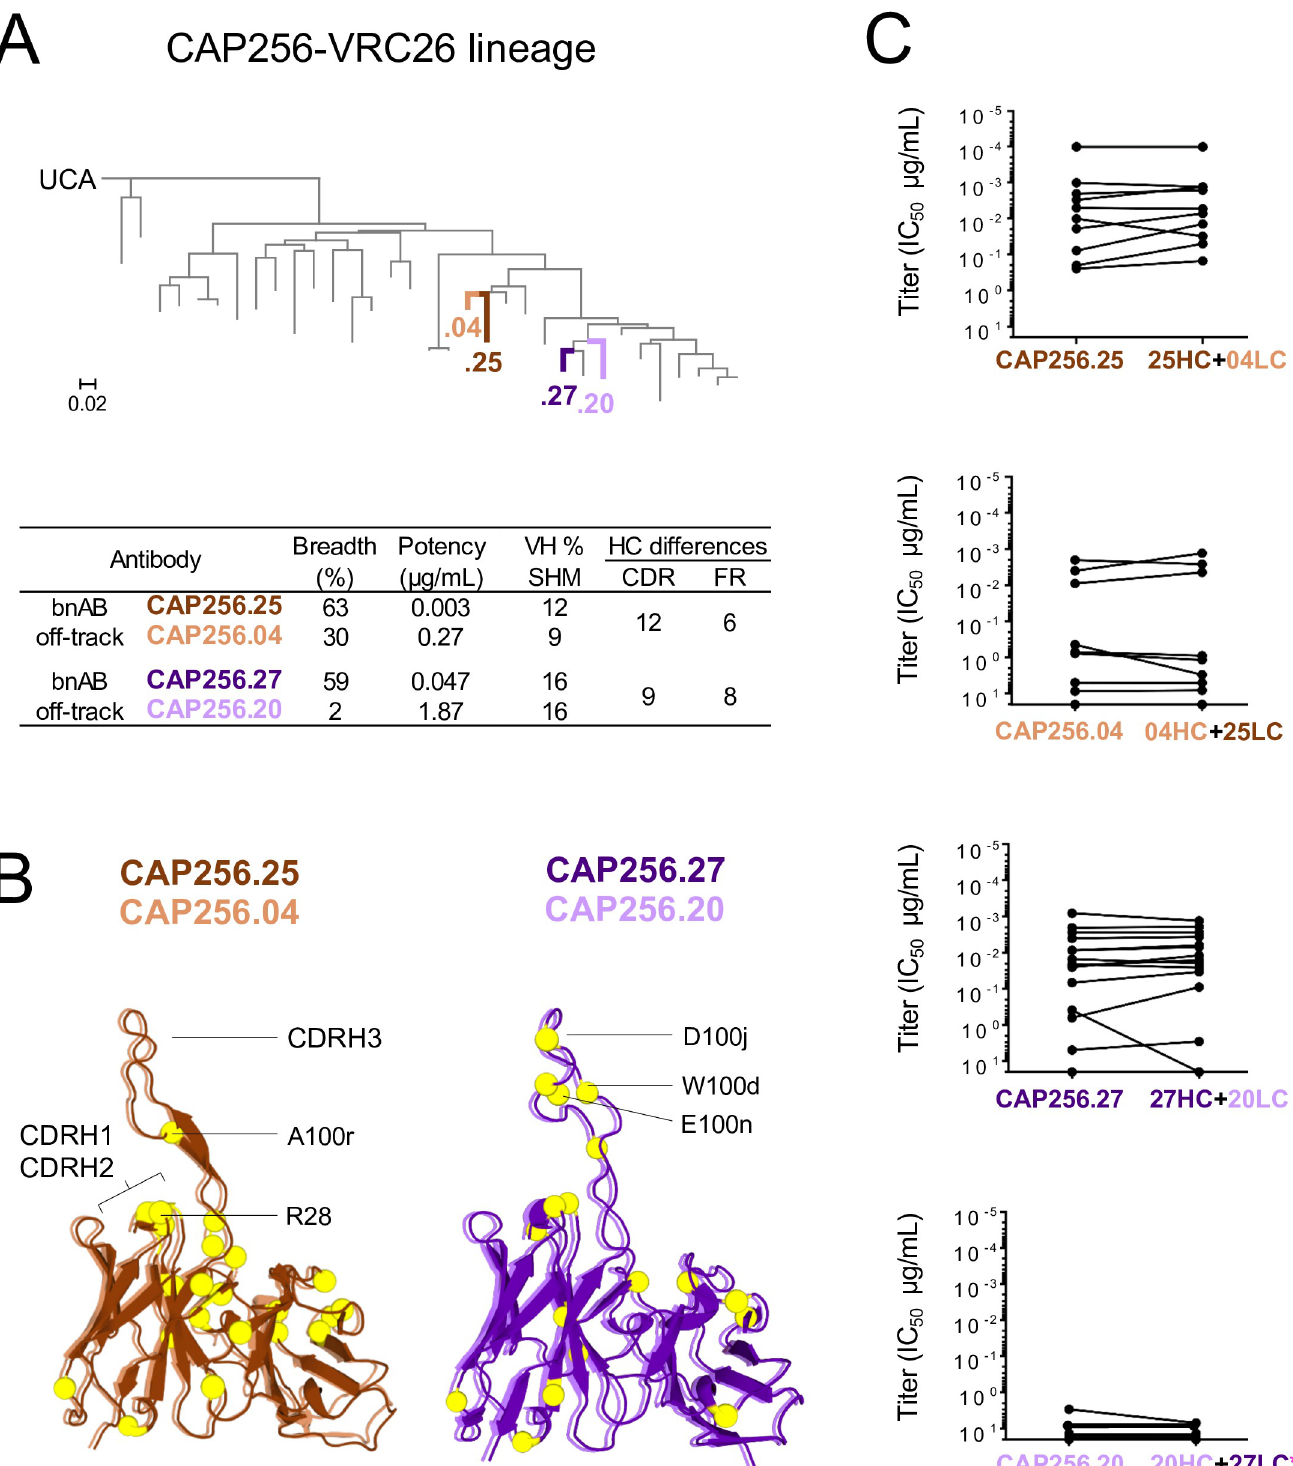
Fig 1. The HC mediates the off-track phenotype. (A) Maximum likelihood phylogenetic tree, rooted on the CAP256.UCA, with 33 clonally related VH sequences of monoclonal antibodies isolated from donor CAP256. Highlighted are CAP256.04 (orange), CAP256.25 (brown), CAP256.20 (light purple) and CAP256.27 (purple). Neutralization breadth, potency, VH SHM (related to CAP256.UCA) and the number of amino acids that differ between the CDR and FR of each pair are tabulated below. Breadth and potency (mean IC 50 ) was calculated from a panel of 46 heterologous viruses [11]. (B, left) The amino acid sequence of CAP256.04